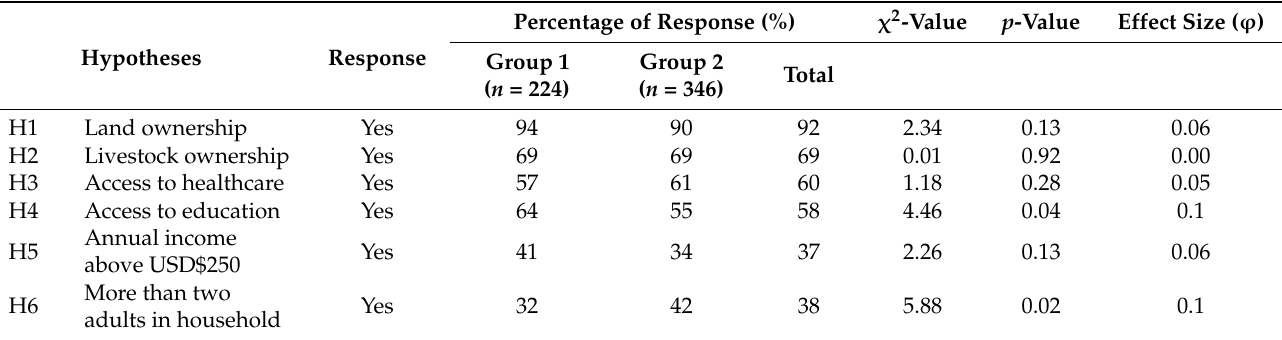
Table 3. Ownership of livelihoods assets.